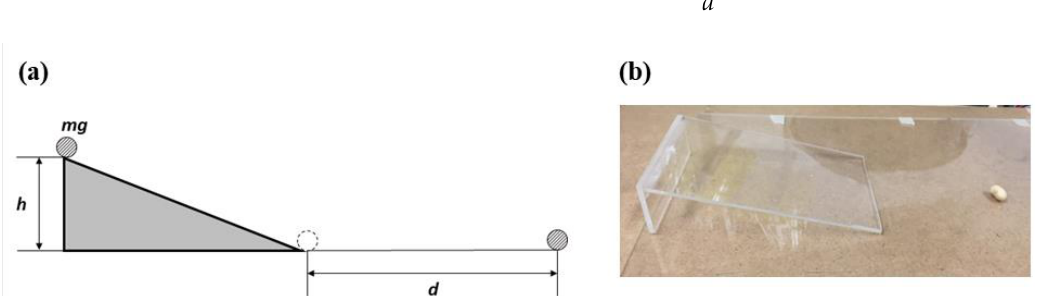
Figure 4. Schematic drawing ( a ) and image ( b ) of the apparatus to measure the coefficient of rolling friction.